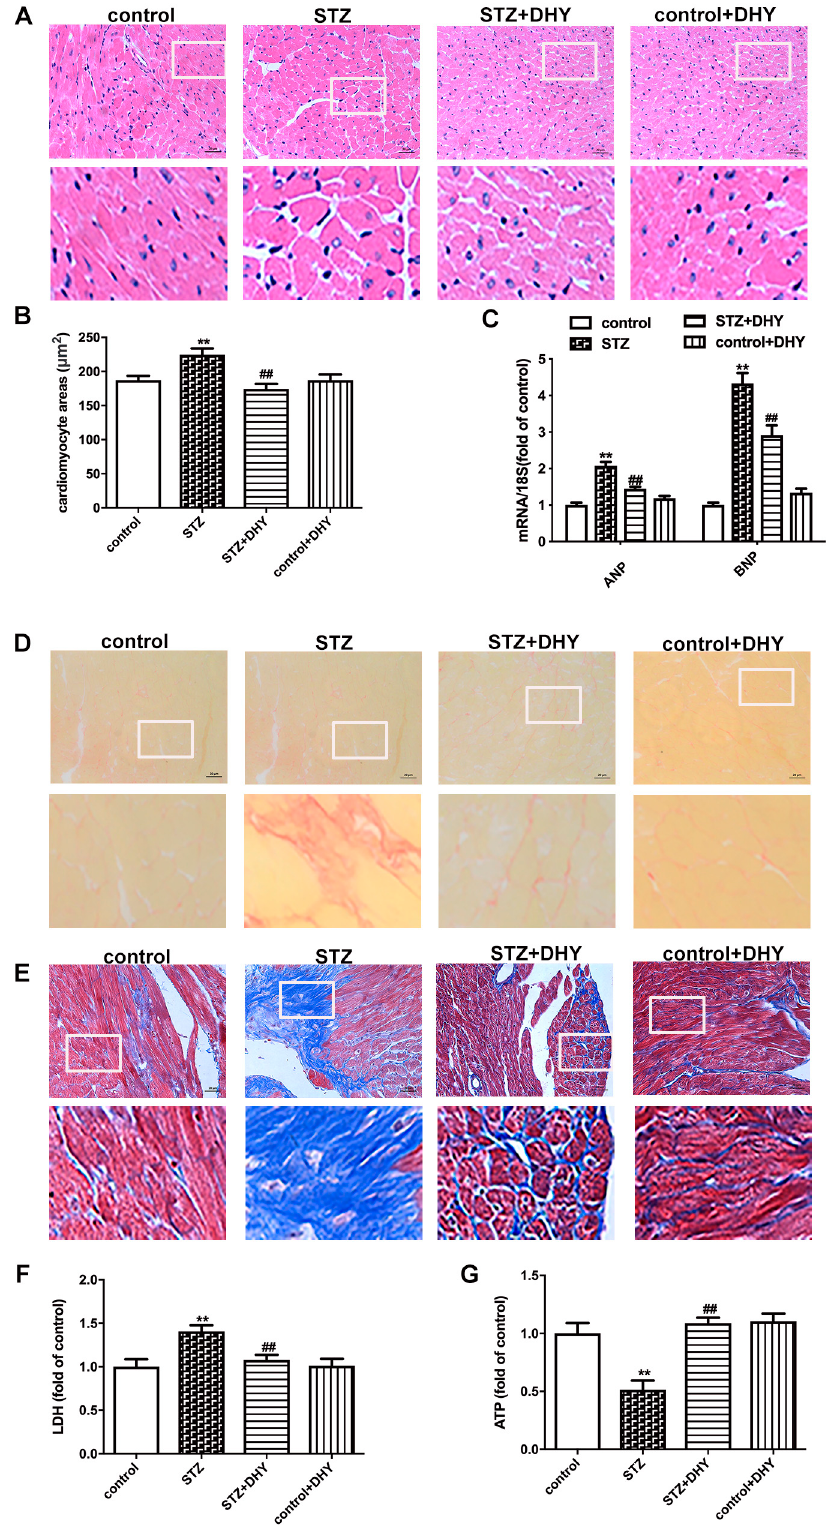
Figure 3. DHY ameliorated myocardial hypertrophy, fibrosis and injury in STZ-induced C57BL/6 mice. ( A ) The representative images of ventricle tissue with HE staining (bar = 20 µ m). ( B ) Cardiomyocyte areas. ( C ) Expression of ANP and BNP mRNA. ( D – E ) The representative images of the myocardium with sirus red staining and Masson’s staining (bar = 20 μ m). ( F ) LDH in the serum. ( G ) ATP level in the myocardium. ** p < 0.01 versus control, ## p < 0.01 versus STZ, n = 6.